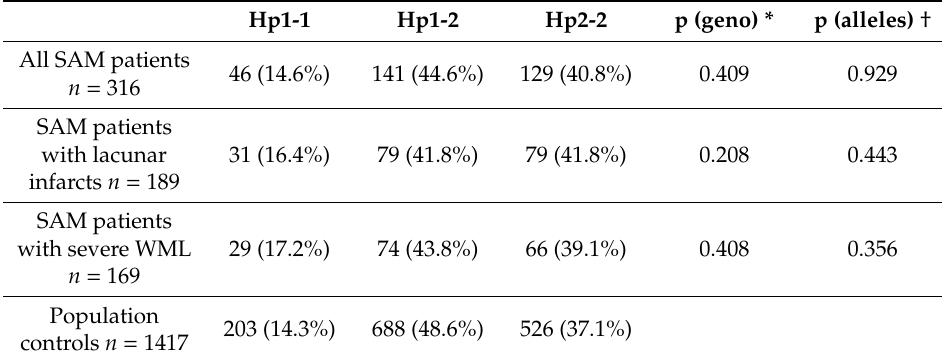
Table 2. Haptoglobin genotypes in stroke patients with lacunar infarcts or severe WML compared to